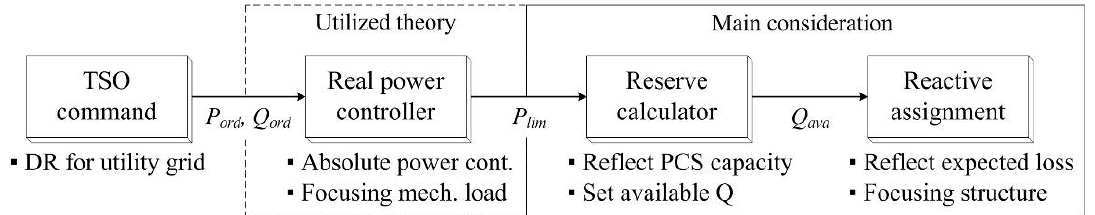
Figure 2. Core control flowchart of the proposed method.